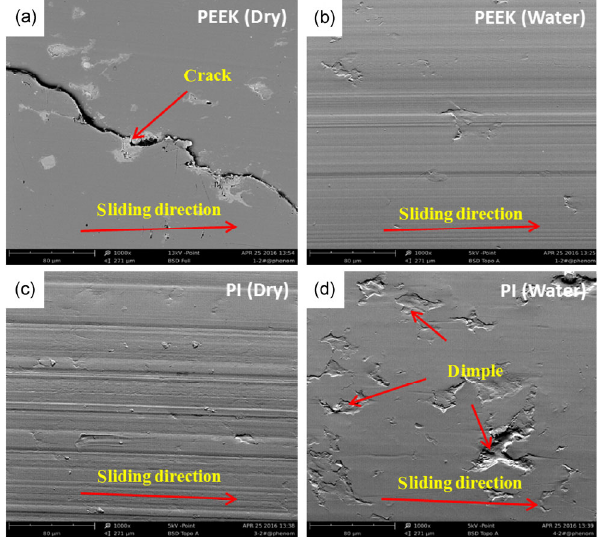
Fig. 14 SEM micrographs of PEEK disk (a, b) and PI disk (c, d) after tests under different lubrications: dry environment (a, c) and water environment (b,